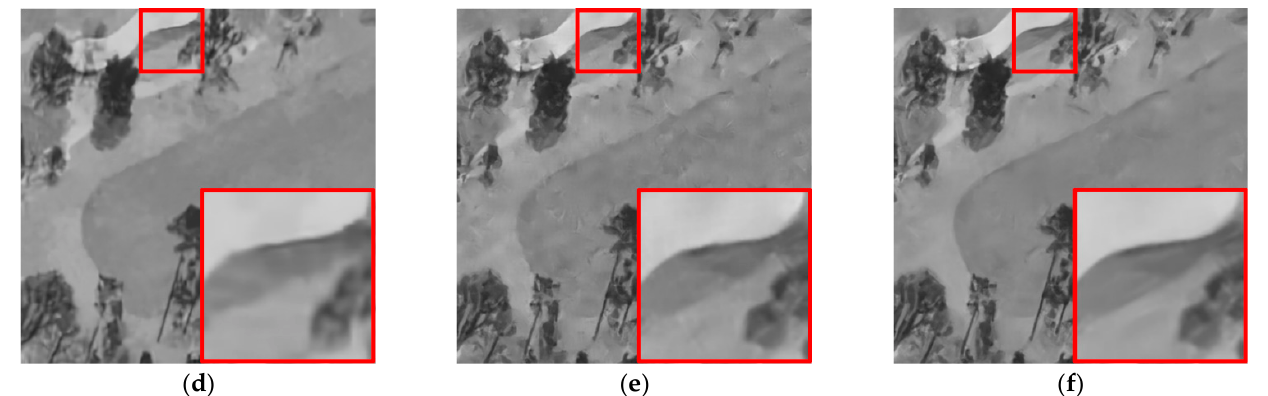
Figure 8. Filtered images of different methods for golf course test image contaminated by four-look speckle. ( a ) Original image, ( b ) noisy image, ( c ) PPB, ( d ) SAR-BM3D, ( e ) ID-CNN, ( f ) proposed.